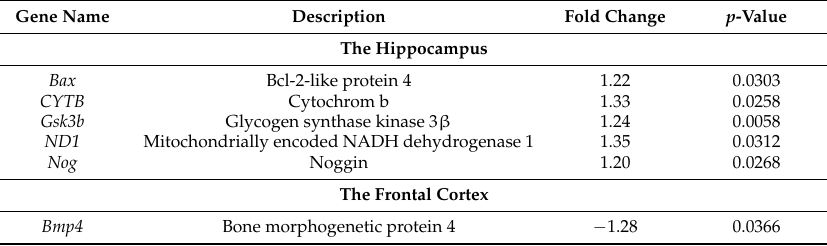
Table 2. The statistically significant differences in the relative gene expression between Alda-1-treated apoE − / − group vs. untreated apoE − / − group in the hippocampus and the frontal cortex ( p < 0.05, n = 3).